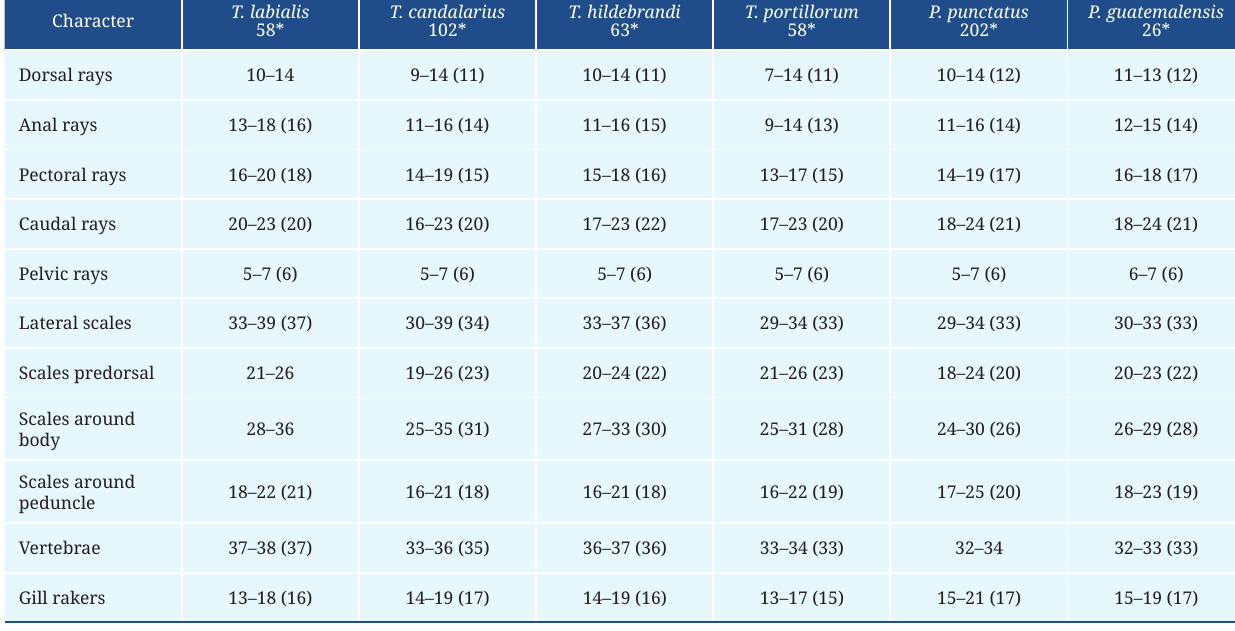
TABLE 2 | Meristic data of Tlaloc and Profundulus species. Asterisk mark the number of specimens analyzed, in parenthesis the modal